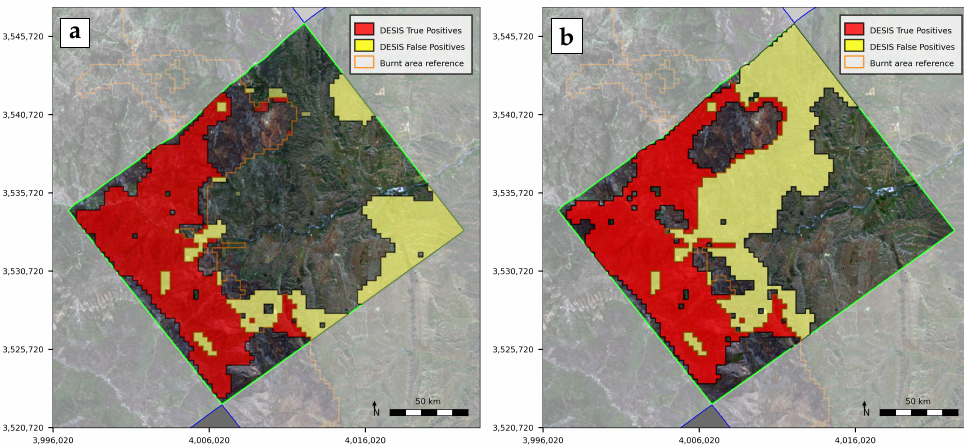
Figure 4. Results utilizing different red/NIR combinations. Subfigure ( a ) depicts the results gained with combination 22/30, while subfigure ( b ) shows the results for combination 25/40 (4 ×